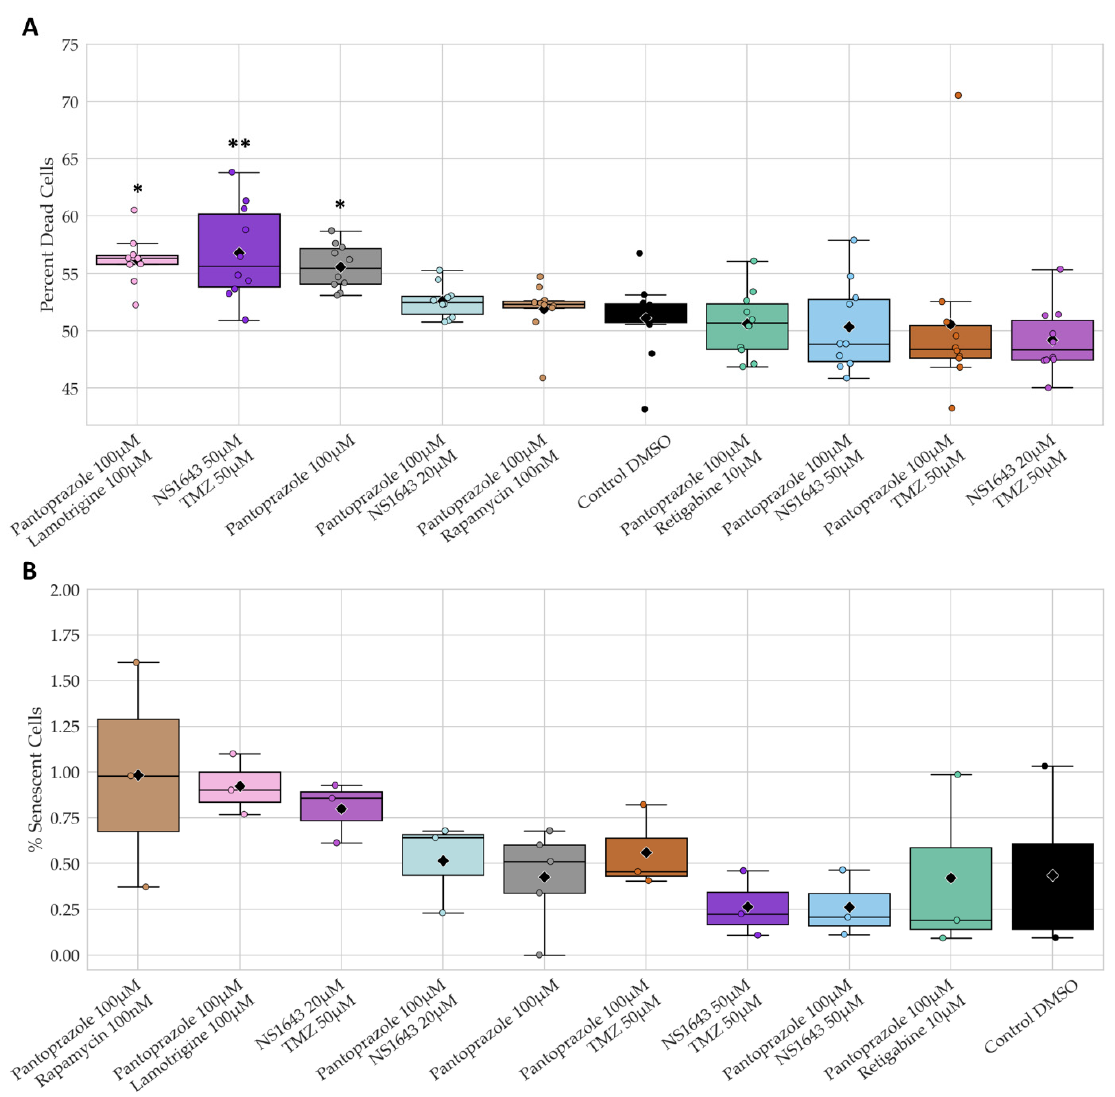
Figure 16. Live/Dead assay and Senescence assay of Human Neuronal Cells After 3 Day Treatment Shows Low Level of Toxicity. Low values indicate less death or senescent cells. ( A ) Live/Dead assay conducted on human neuronal cells cultured with drug for 3 days. ( B ) Senescence assay results of senescence associated beta-galactosidase staining on human neuronal cells cultured with drug for 3 days. Treatments with best reduction of proliferation in NG108-15 or U87 cells are shown out of a 24-sample toxicity screen, with significant values shown. **: q < 0.01, * : q < 0.05 (one-way ANOVA with FDR post hoc analysis n > 3 technical replicates). Increase in percent dead or senescent cells indicative of toxic treatment.